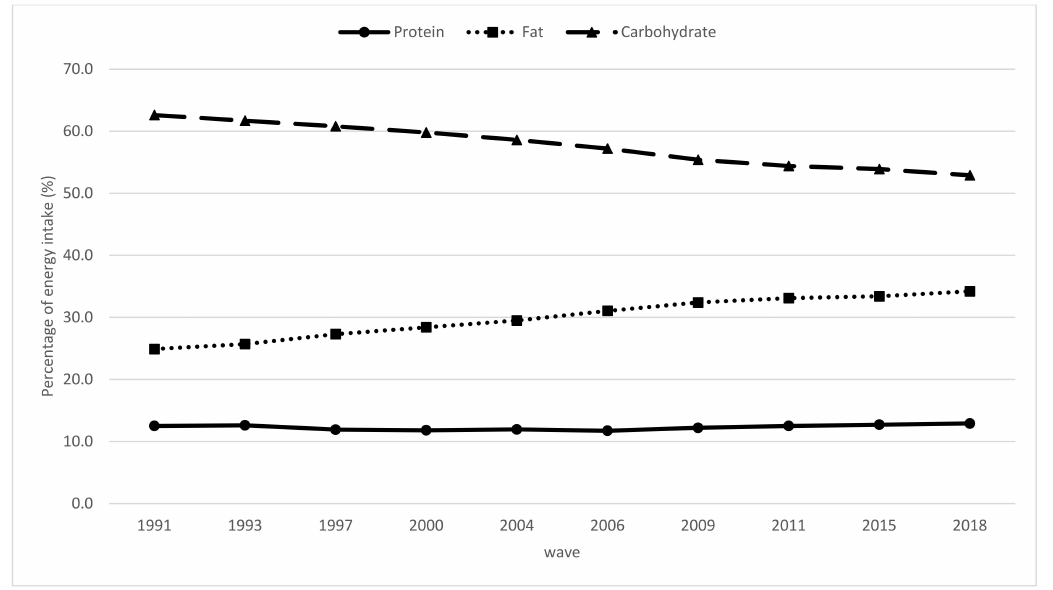
Figure 2. Trends in percentage of energy from protein, fats, and carbohydrates, among the elderly Chinese by wave from 1991 to 2018 ( p < 0.05 for the trend for